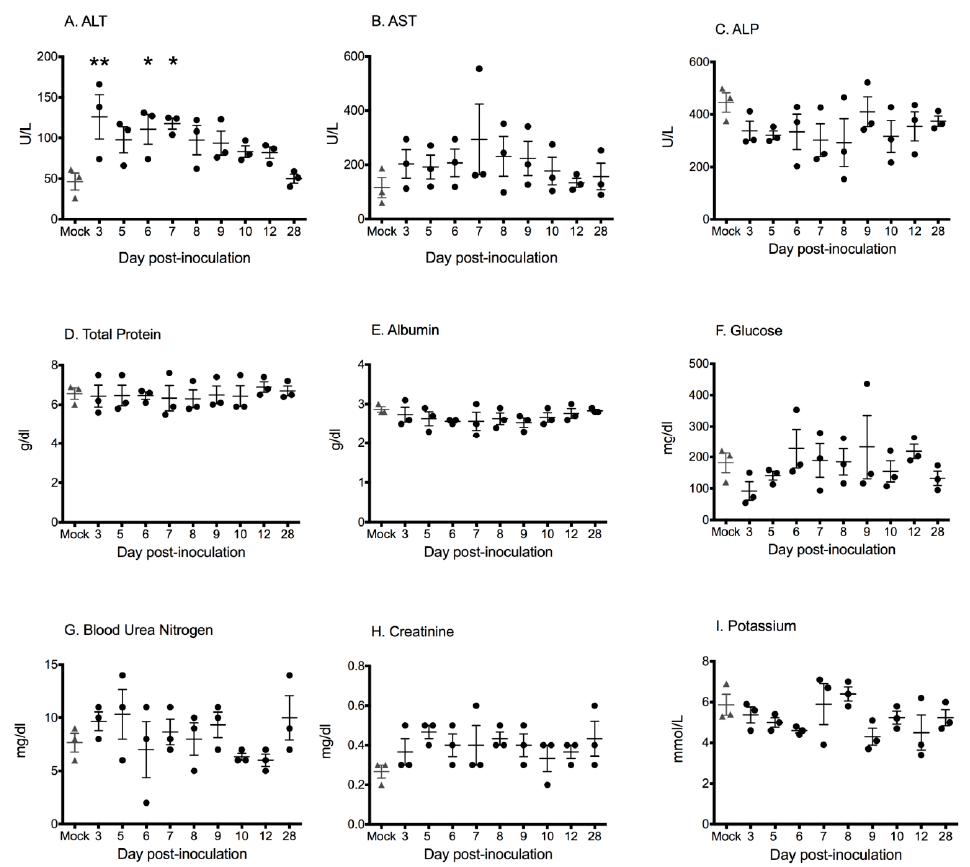
Figure 2. Blood chemistry values for Egyptian rousette bats experimentally inoculated with Marburg virus in a serial euthanasia study. Each point represents the chemistry parameter value measured for an individual bat on the day of euthanasia (3 bats euthanized per time point); bars represent mean ± SEM per day. ( A ) Alanine aminotransferase = ALT. Alanine aminotransferase was significantly increased in bats tested on day 3, 5, and 7 relative to mock-inoculated bats (asterisks). ( B ) Aspartate aminotransferase = AST. ( C ) Alkaline phosphatase = ALP. ( D ) Total protein. ( E ) Albumin. ( F ) Blood glucose. ( G ) Blood urea nitrogen. ( H ) Creatinine. ( I ) Potassium.